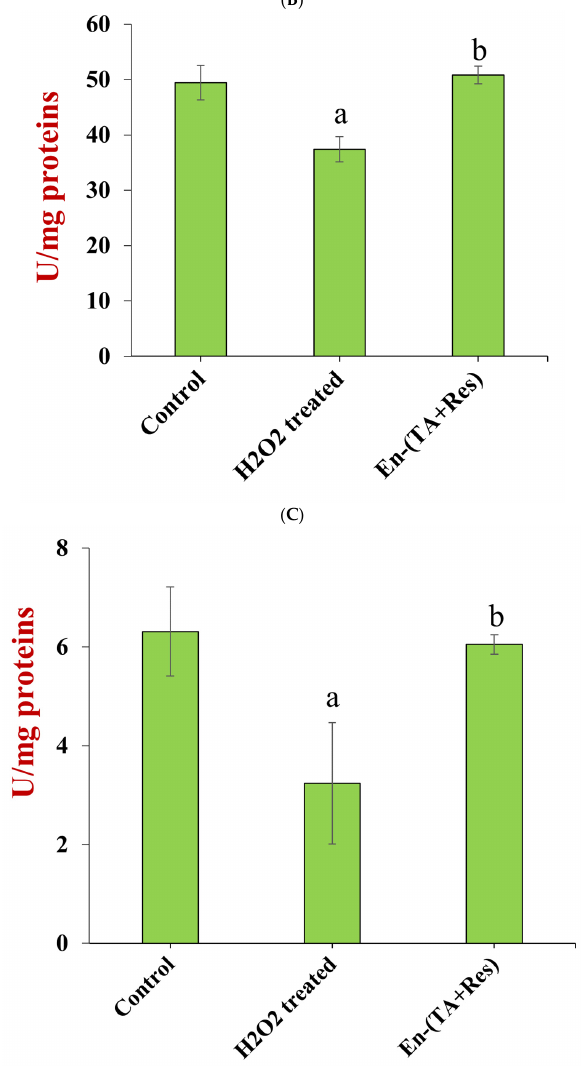
Figure 9. Effect of co-encapsulated tannic acid and resveratrol (En-(TA+Res)) on the concentration of MDA ( A ), activity of SOD ( B ), and activity of CAT ( C ) in HepG2 cells treated with H 2 O 2 (the letter “a–b” represents a statistically significant difference between two groups, p < 0.05).